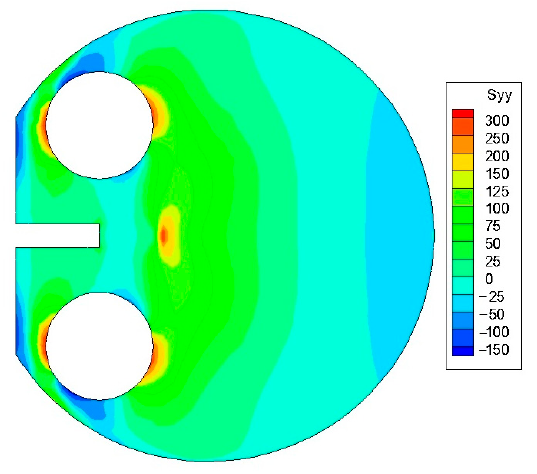
Figure 7. Stress contour plots of σ yy for the RCT specimen. (Unit: MPa).